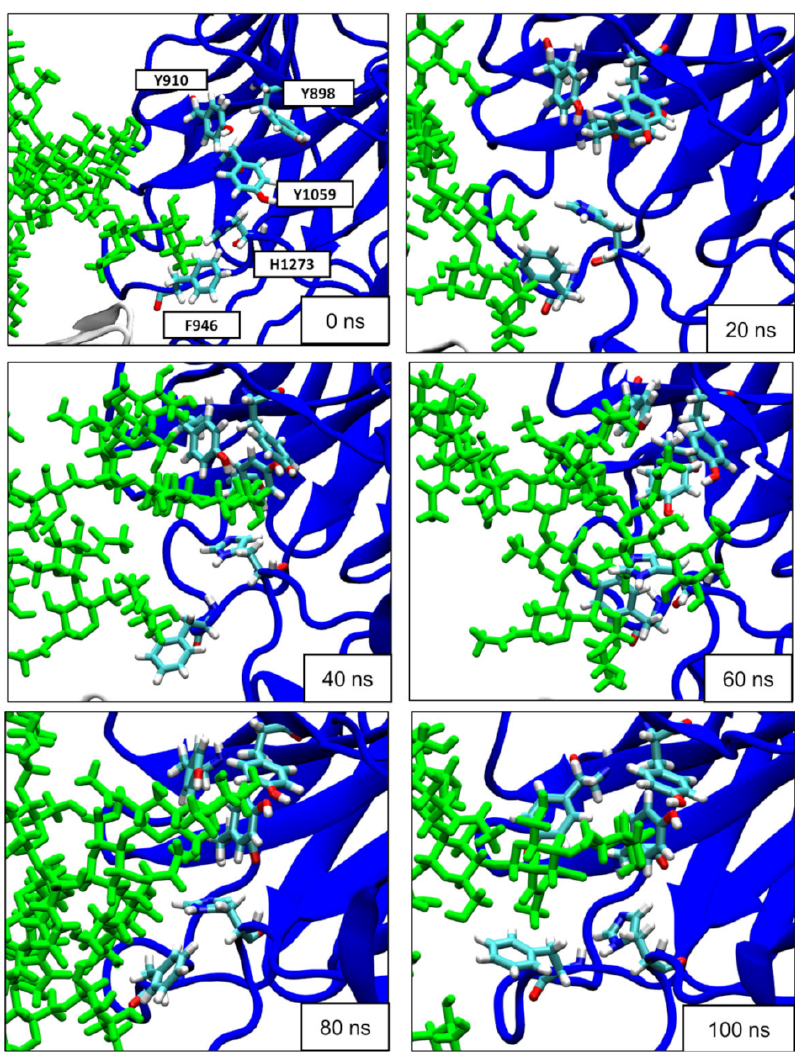
Figure 5. Evolution of interactions between BoNT/F1 and glycan content of hSV2Ag at 0, 20, 40, 60, 80 and 100 ns. BoNT/F1 is depicted as blue cartoon, the aromatic residues of BoNT/F1 that interact with the glycan are depicted as sticks colored according to atom name, and N-glycan is depicted as sticks colored in